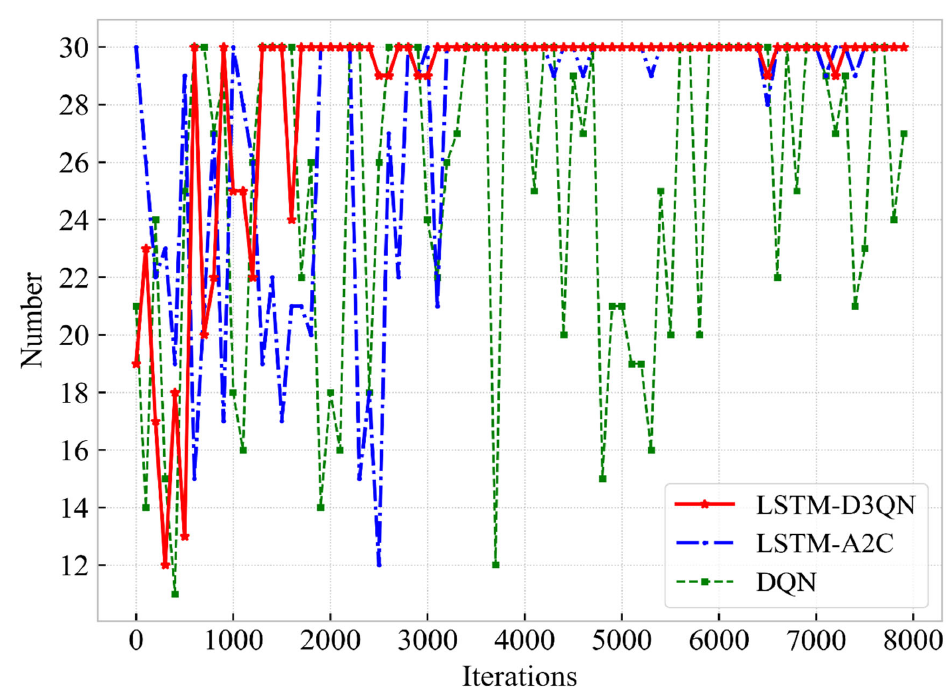
Figure 4. The comparison of the number of dual ‐ connected users for different methods.